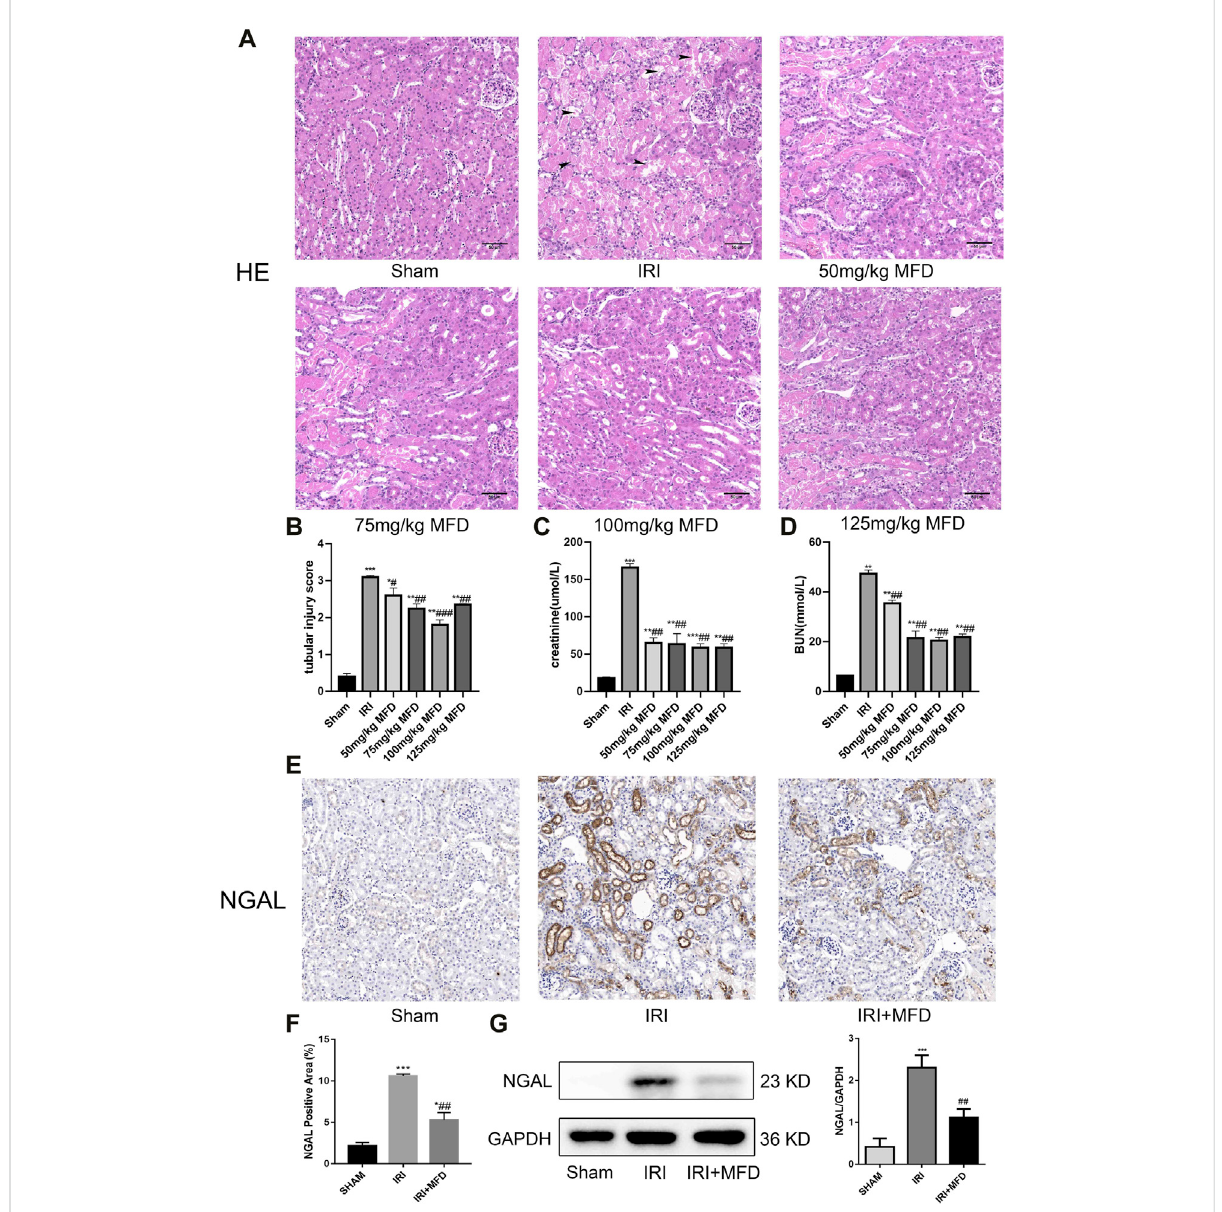
Mefunidone ameliorated IRI-induced AKI (A) HE staining showed protective effect of mefunidone at various doses of 50 mg/kg, 75 mg/kg, 100 mg/kg,125 mg/kgonrenaltubularinjury onday2after IRImodeling (×200).arrows forrenaltubulardamage. (B) Thetubularinjuryscores ofHE stainingforkidneydamage. (C) Serumcreatinine(SCr)levelsofmefunidoneatvariousdosesof50 mg/kg,75 mg/kg,100 mg/kg,125 mg/kgonrenal tubular injury on day 2 after IRI modeling. (D) Blood urea nitrogen (BUN) levels of mefunidone at various doses of 50 mg/kg, 75 mg/kg, 100 mg/kg,125 mg/kgonrenal tubularinjury onday2after IRImodeling. (E,F) Histological images ofimmunohistochemical stainingwith NGALand evaluationofNGALpositiveareaineachgrouponday2afterIRImodeling(×200).Mefunidone:100 mg/kg. (G)